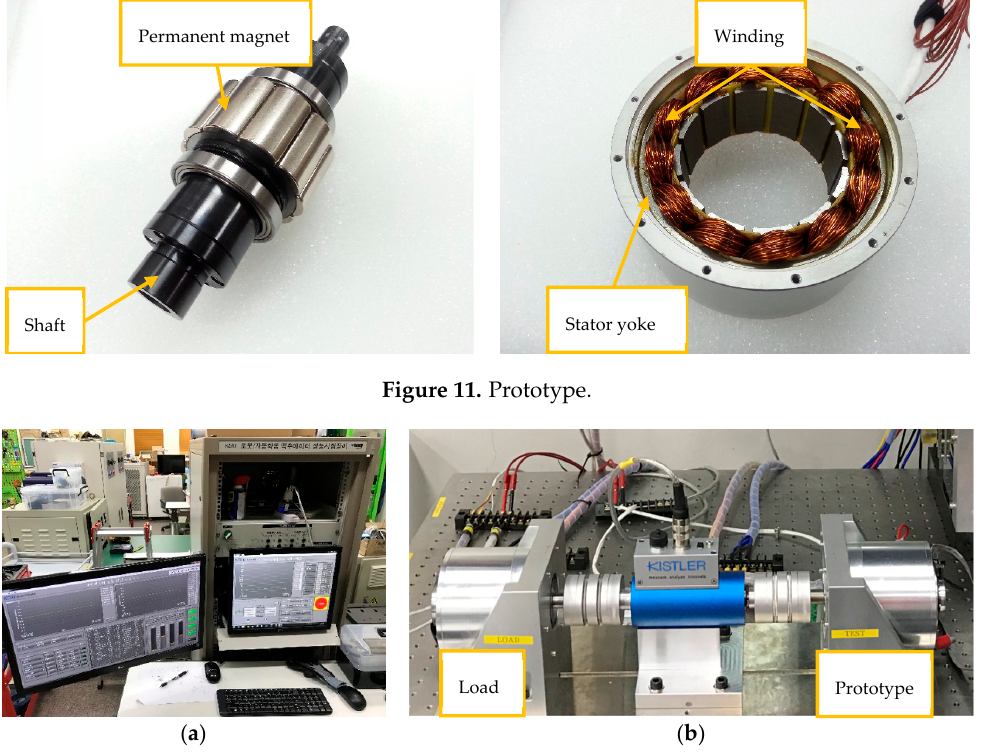
Figure 12. Experimental setup: ( a ) Human machine interface; ( b ) back-to-back system.